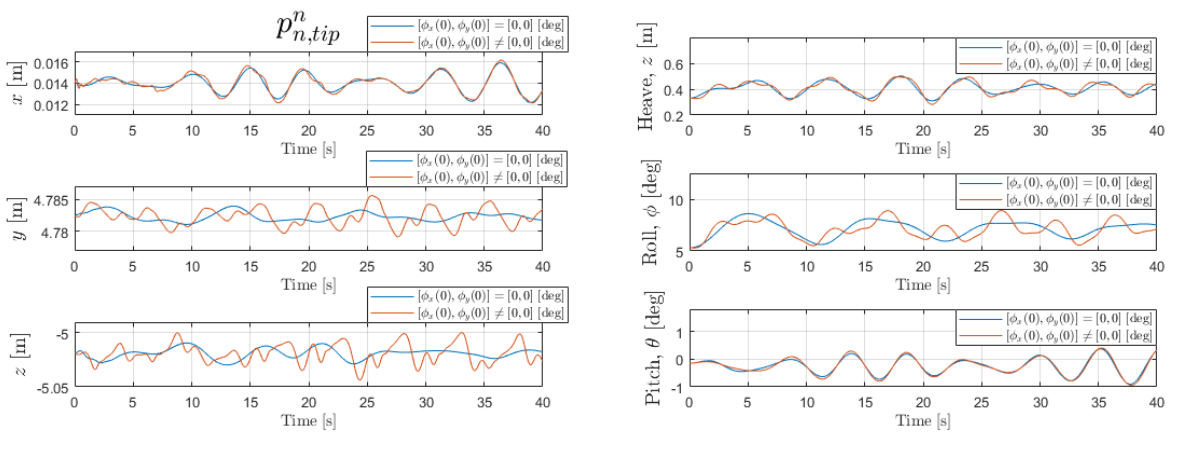
Figure 11: Heave z , roll φ and pitch θ motions of the vessel. The blue graph is the vessel’s motions due to orientations [ φ x , φ y ] of the swinging pendulum with initial conditions [ φ x (0) , φ y (0)] ≈ [0 ◦ , 0 ◦ ]. The red graph is the vessel’s motions due to orientations [ φ x , φ y ] of the pendulum with initial condi- tions [ φ x (0) , φ y (0)] ≈ [ − 45 ◦ , 45 ◦